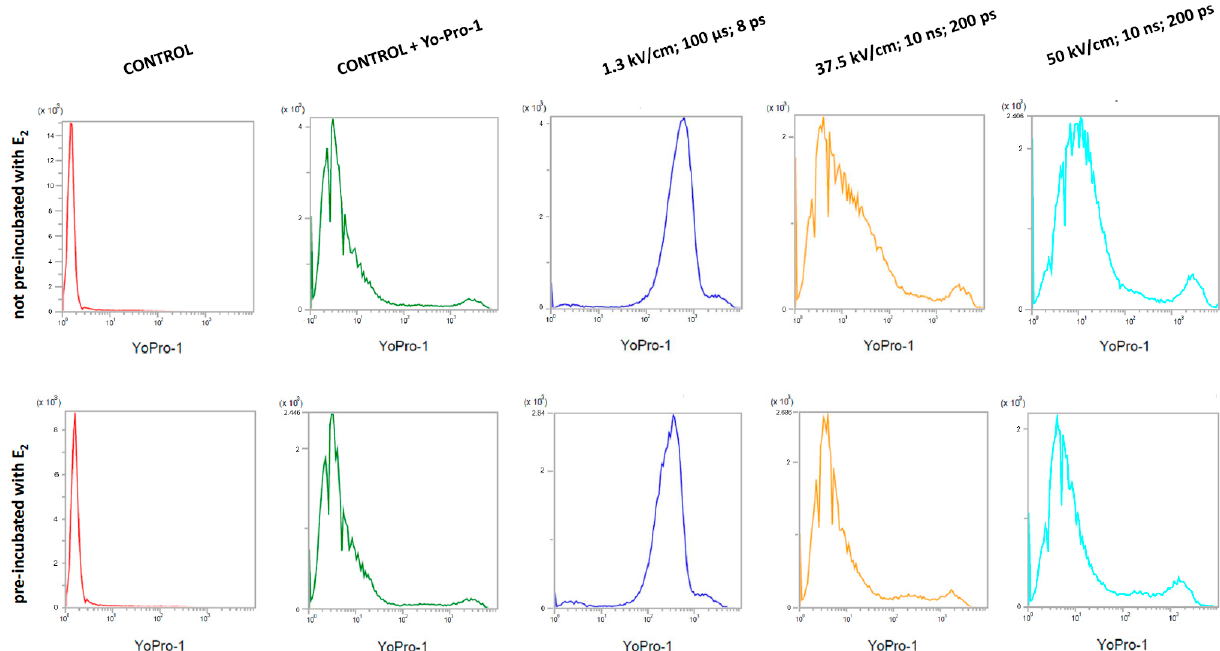
Figure 7. Yo-Pro-1 TM fluorescent dye absorption in MDAH-2774 cells after µ EP and nsEP; ps—pulses.